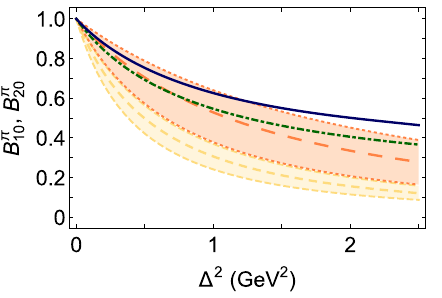
Fig. 6 Twist-two tensor form factors, Eq. (59), normalised to unity at t = 0 using the results in Eq. (60): dot-dashed green curve – B π ; 10 and solid blue curve – B π . Normalised this way, the depicted form 20 factors are independent of the renormalisation scale. For comparison, lQCD results from Ref. [100]: short-dashed yellow curve within like- coloured band – B π and long-dashed orange curve and band – B π . As 10 20 in Fig. 3, the bands enclose the envelope of curves that fit the lQCD results